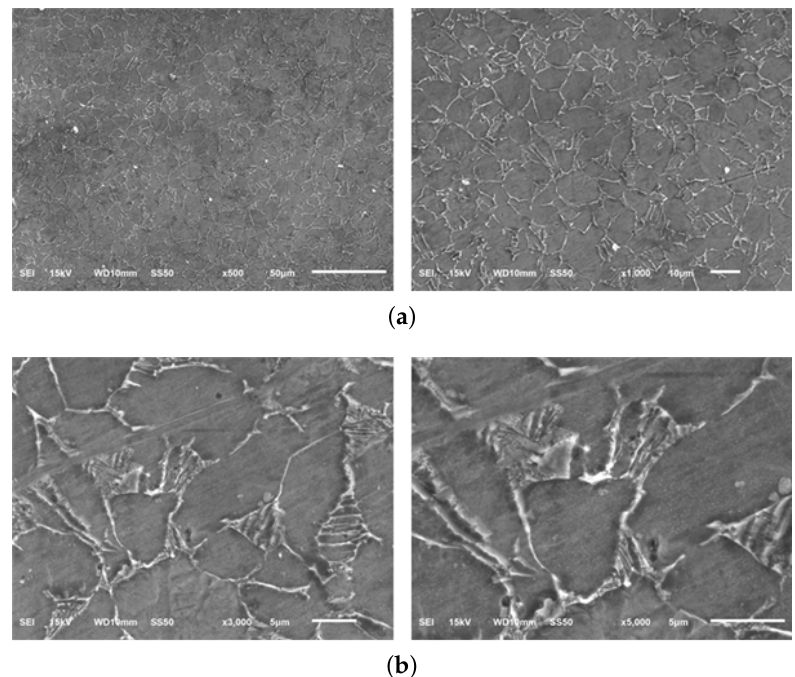
Figure 13. Microstructure of Material sample A-H—Scanning Electron microscopy (SEM). ( a ) Material sample A-H (500 and 1000 × ); ( b ) Material sample A-H (3000 and 5000 ×